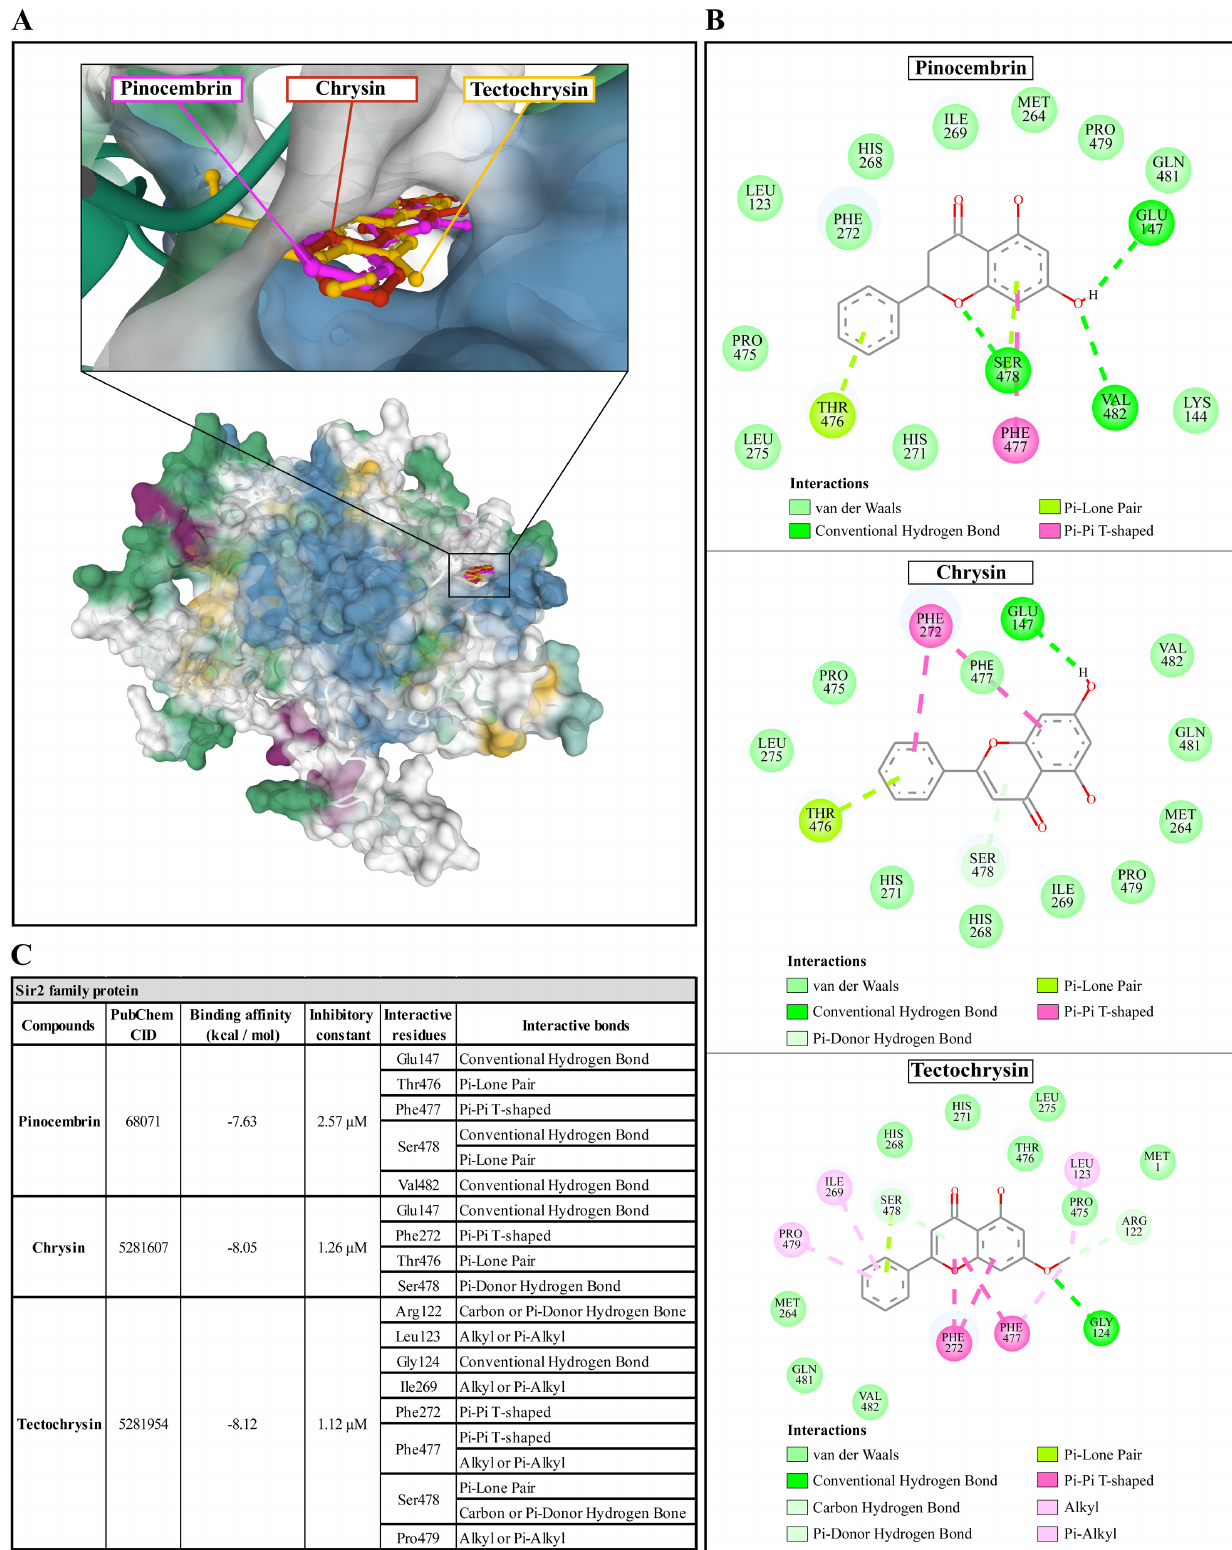
Figure 4. The interaction of pinocembrin, chrysin, and tectochrysin toward the AcSIR2 protein predicted by molecular docking. ( A ) Binding site of the ligands toward the AcSIR2 protein, purple compound represents pinocembrin, red compound represents chrysin, yellow compound represents tectochrysin. ( B ) A schematic representation of the detailed interactions of the ligand atoms with the protein residues. ( C ) Binding affinity and inhibitory constant prediction of propolis compounds against Sir2 family protein of Acanthamoeba castellanii . AcSIR2, A. castellanii Sir2 family protein.